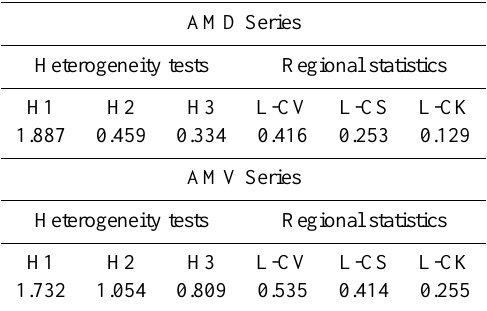
Table 3. Heterogeneity tests and regional statistics of the AMD and the AMV series at the 32nd region.